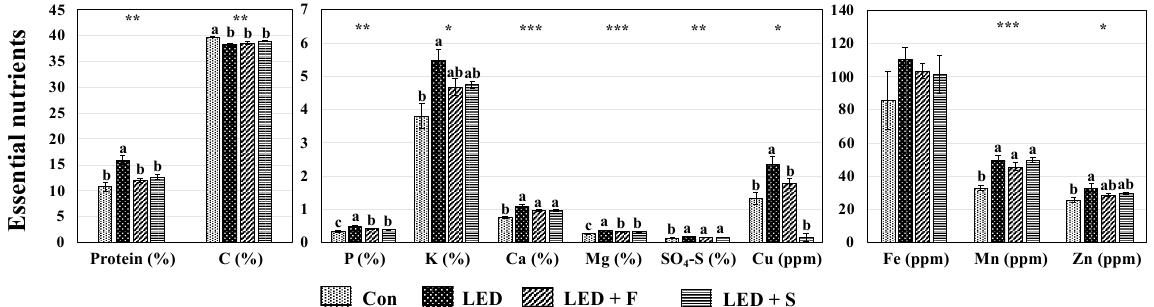
Figure 2. Concentrations of essential nutrients in ‘Two Star’ lettuce subjected to supplemental UV-A radiation. Treatments included LEDs, LEDs + focus lens (LED + F), LEDs + scatter lens (LED + S), and control (Con). Measurements were made after 6 days of treatments. Vertical bars indicate standard errors (n = 4). Bars with different letters are significantly different. Significant differences are presented at p < 0. 05 (*), p < 0.01 (**), and p < 0.001 (***). Table 3. Concentrations of essential nutrients in lettuce variety ‘New Red Fire’ subjected to supple- mental UV-A radiation. Treatments included LEDs, LEDs + focus lens (LED + F), LEDs + scatter lens (LED + S), and control (Con). Measurements were made after 3 and 6 days of